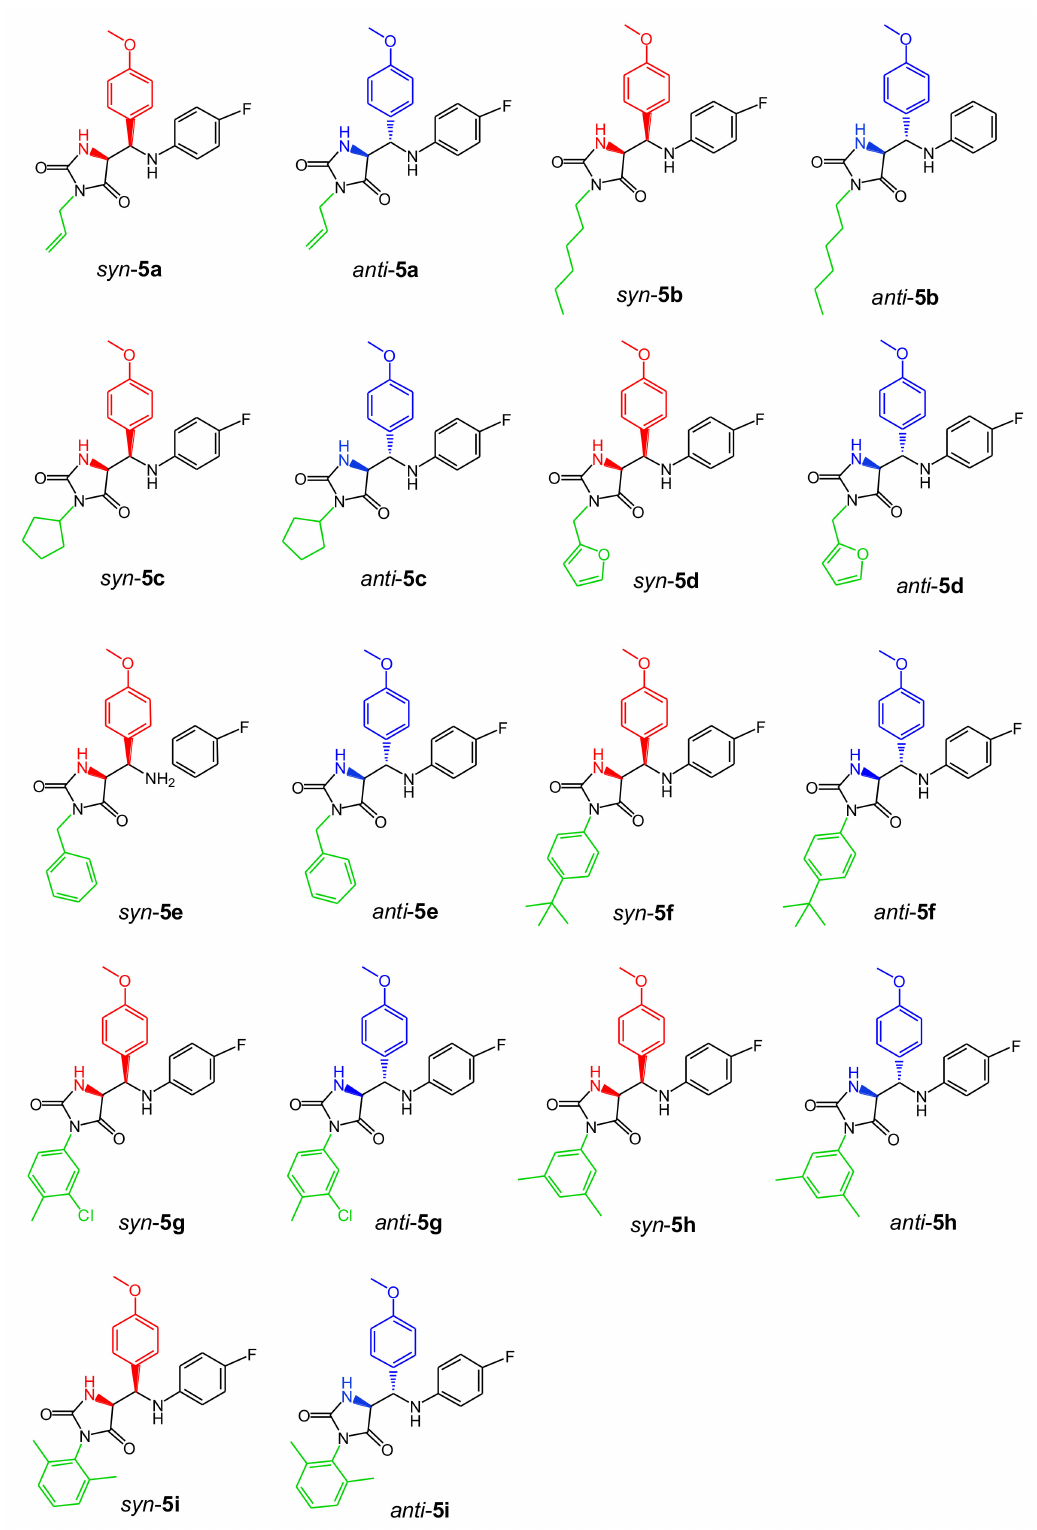
Figure 2. Chemical structures of ( ± )- syn - and ( ± )- anti -3,5-disubstituted hydantoins 5a – i